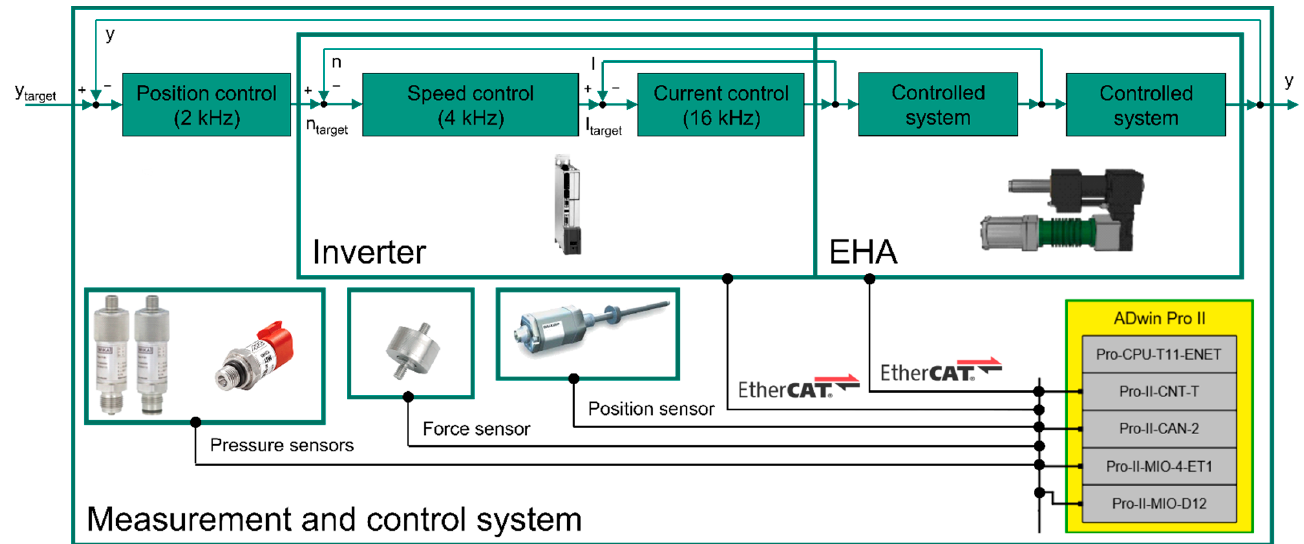
Figure 3. Representation of the control system, the systems involved, and the sensors used.